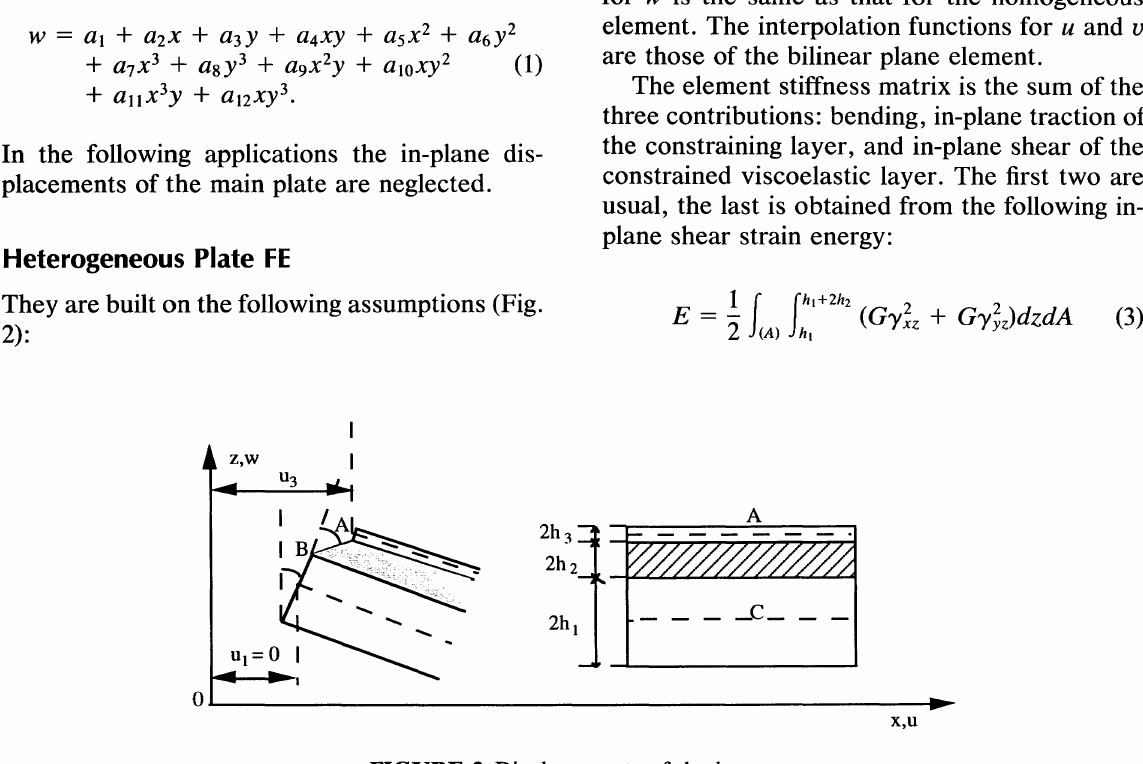
FIGURE 2 Displacements of the